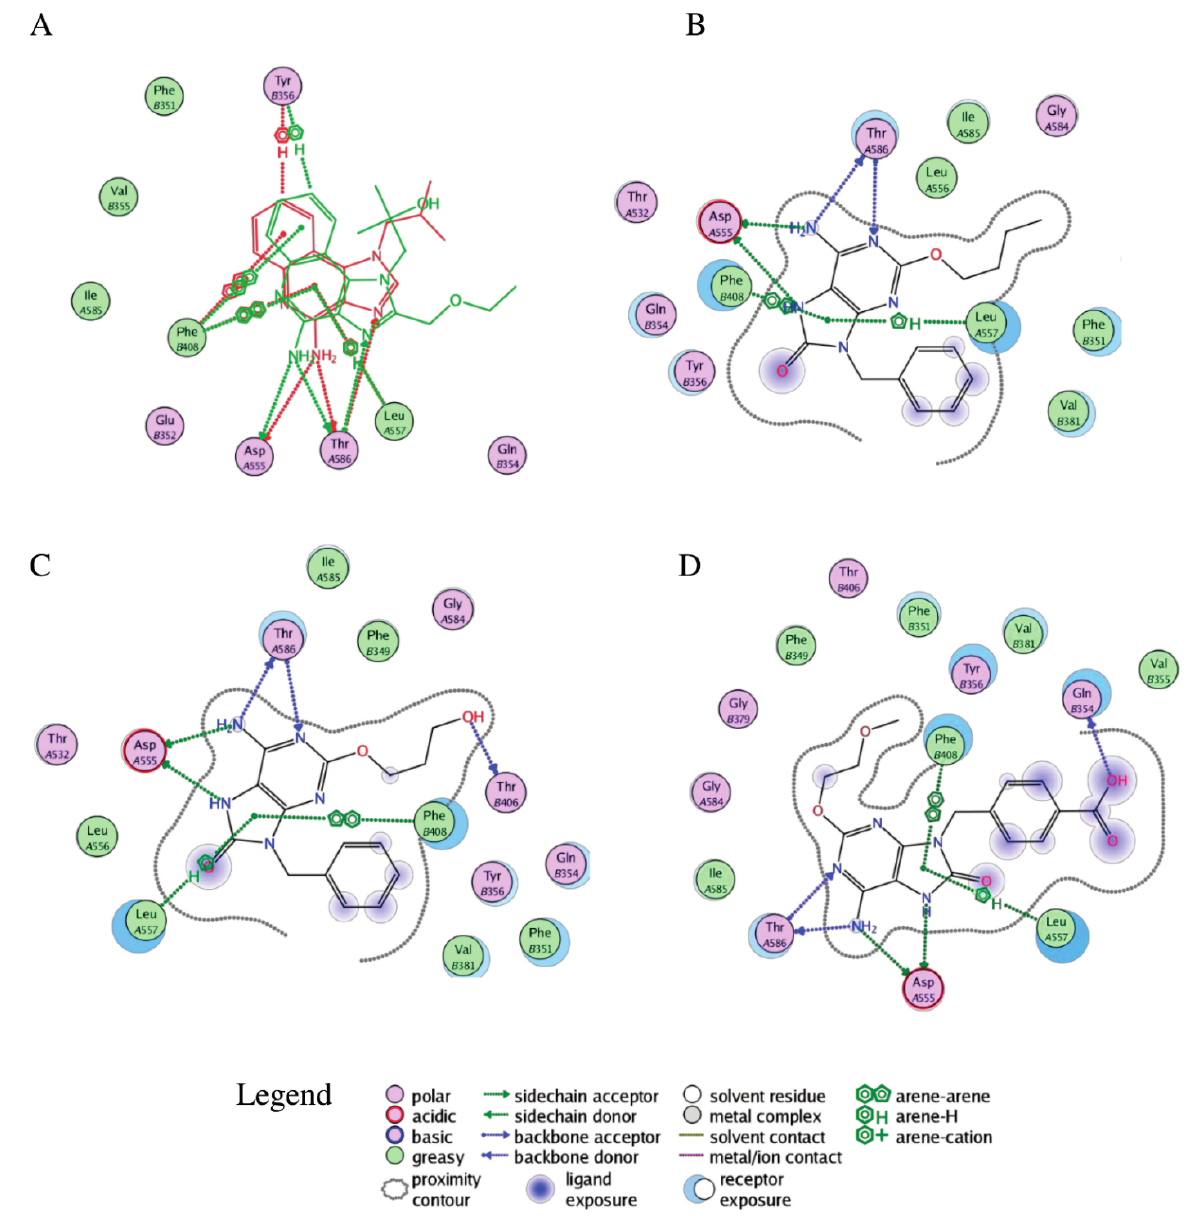
Figure 4. Interactions between selected agonists and TLR7. ( A ) Superimposition of R-837 (red) and R-848 (green) binding poses; ( B ) Binding pose for compound 52455; ( C ) Binding pose for compound 52452; ( D ) Binding pose for compound 1V209. A and B suffixes on the residues refer to the relative TLR7